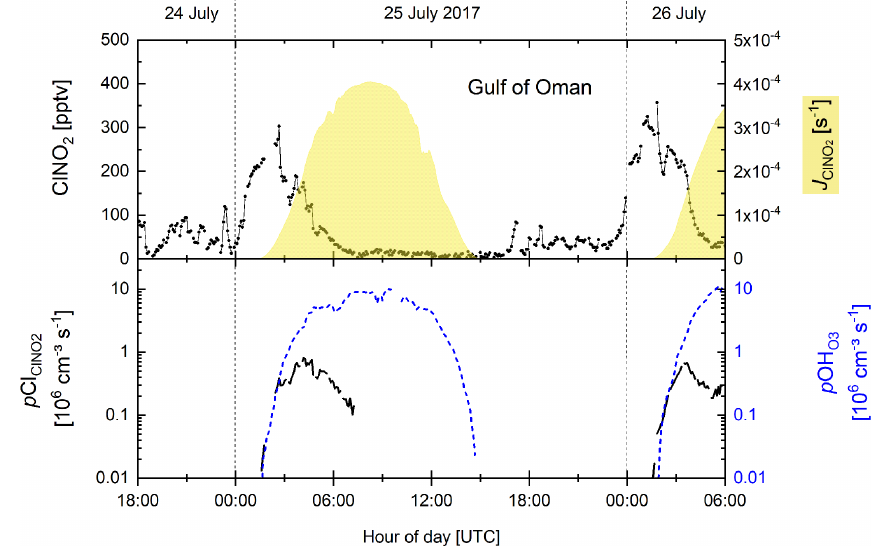
Figure 8. Time series of ClNO 2 mixing ratios, J ClNO and OH radicals from O 3 photolysis in the presence of H 2 O( p OH O